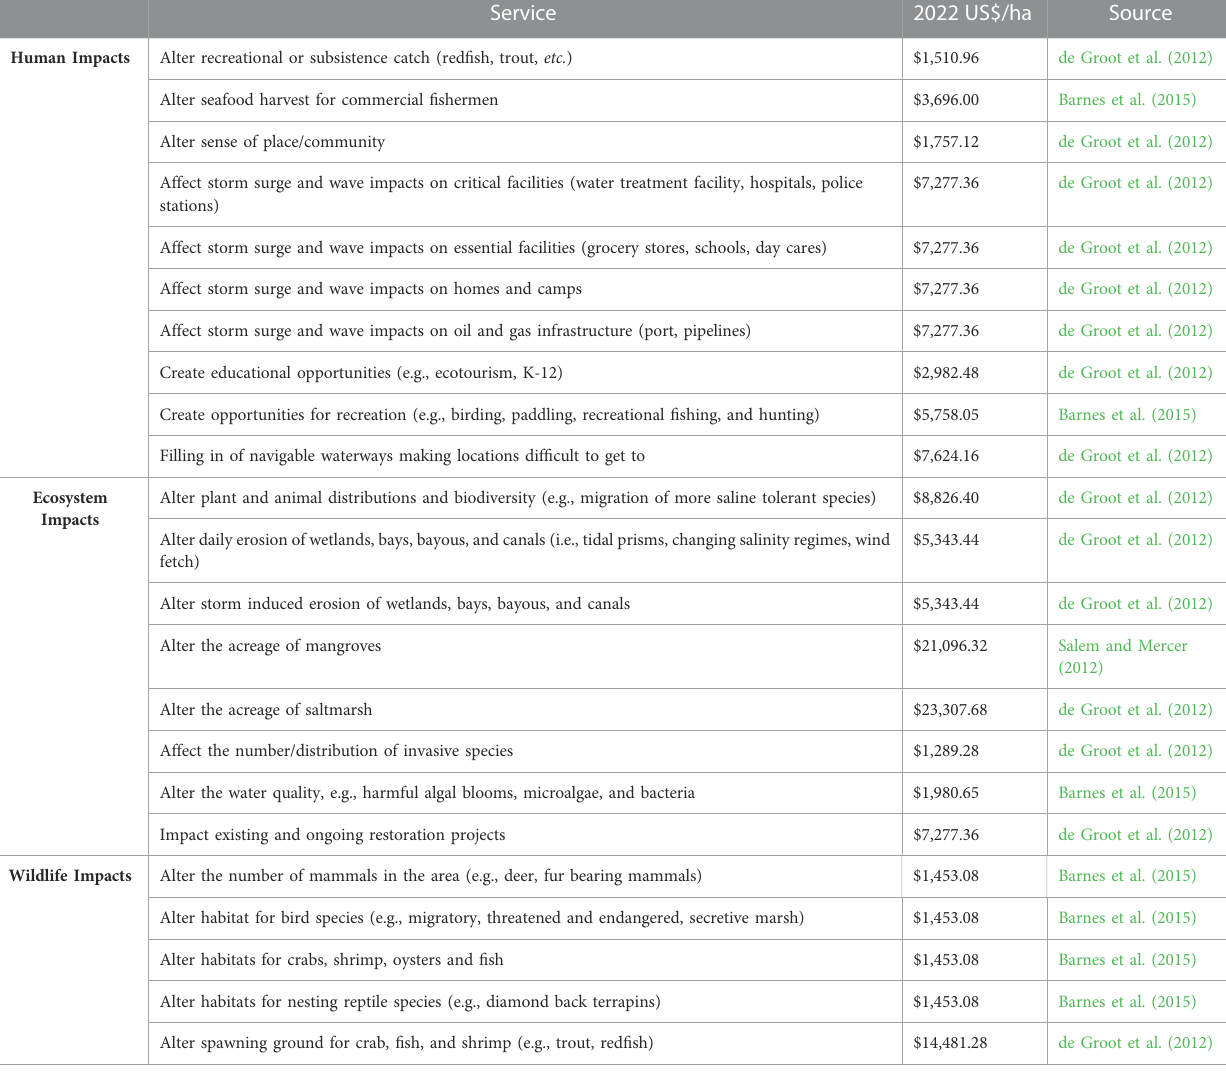
TABLE 5 Financial proxies used to rank project groupings.